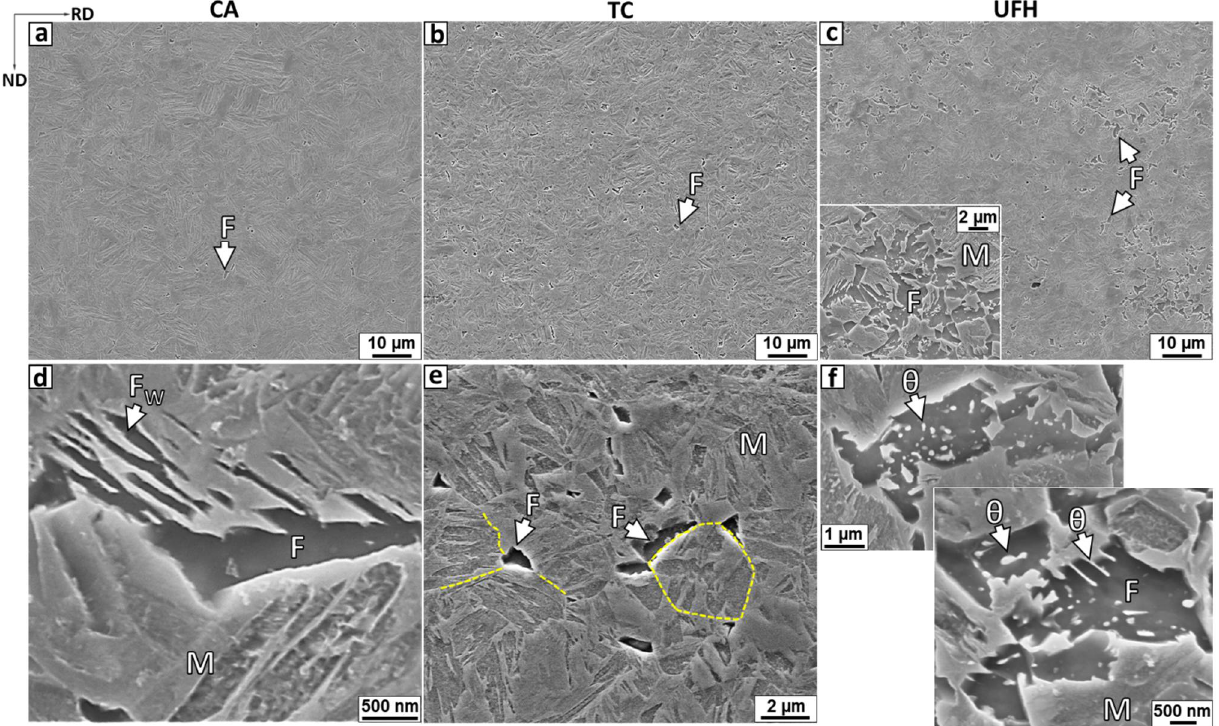
Figure 4. Microstructures of samples directly cooled to room temperature after the annealing step. ( a – d ) CA, ( b – e ) TC and ( c – f ) UFH. In ( e ), prior austenite grain boundaries are highlighted by dashed lines. M: Martensite; F: Ferrite; F W : Widmanstätten ferrite; θ: Undissolved cementite particles.